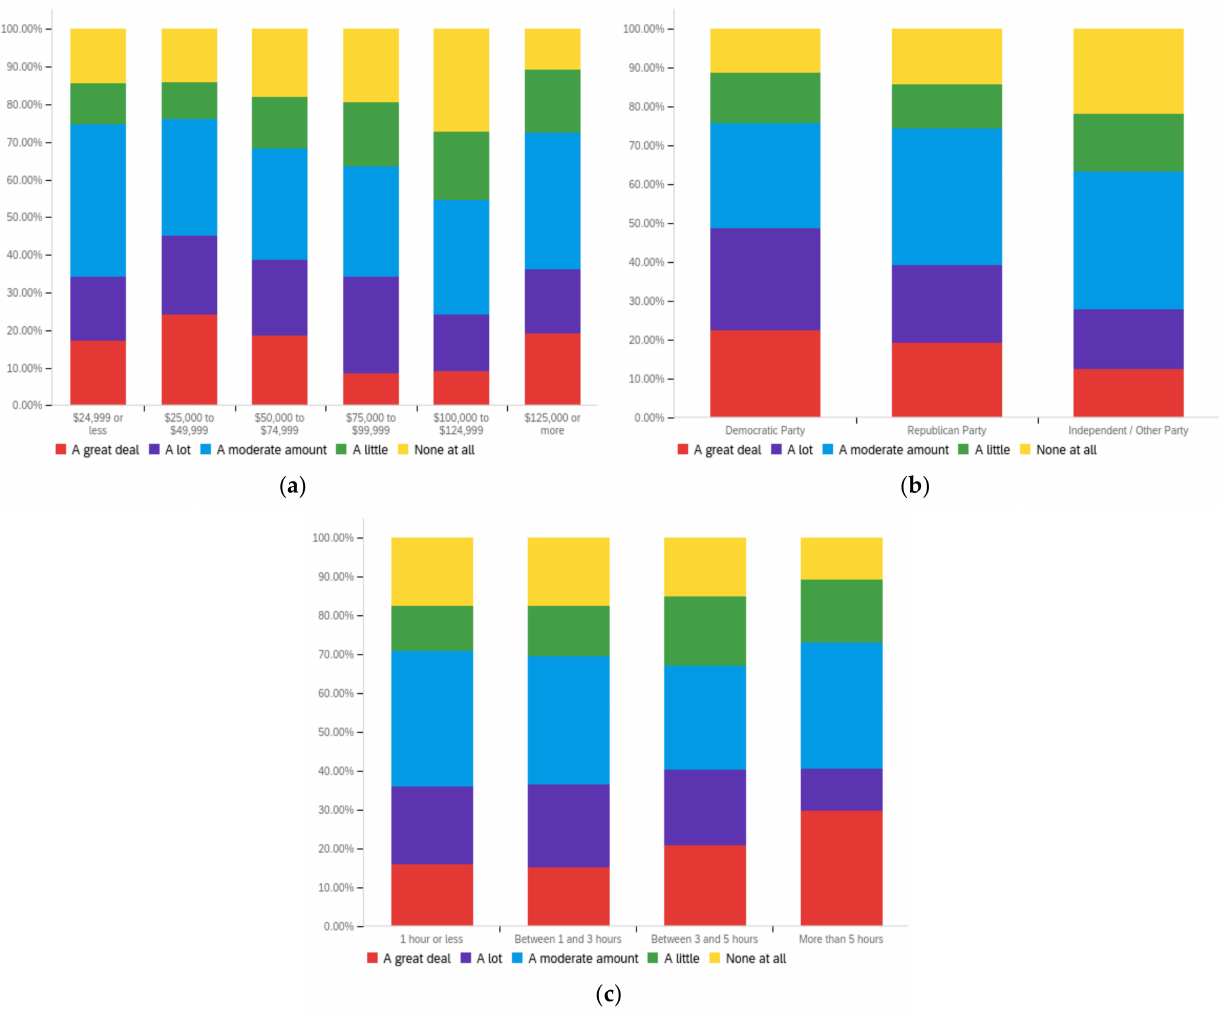
Figure A36. Article reading level—ideal perception impact by: ( a ) income level (top left), ( b ) political affiliation (top right) and ( c ) online usage